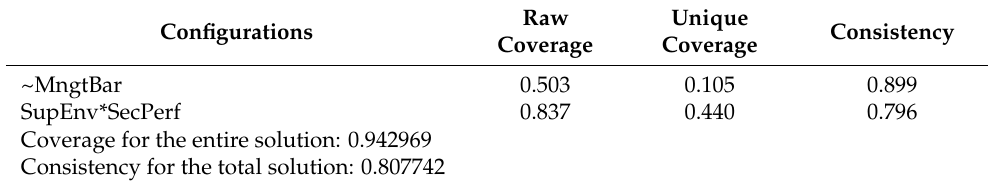
Table 7. fsQCA results: parsimonious solution leading to effects of digitalization.